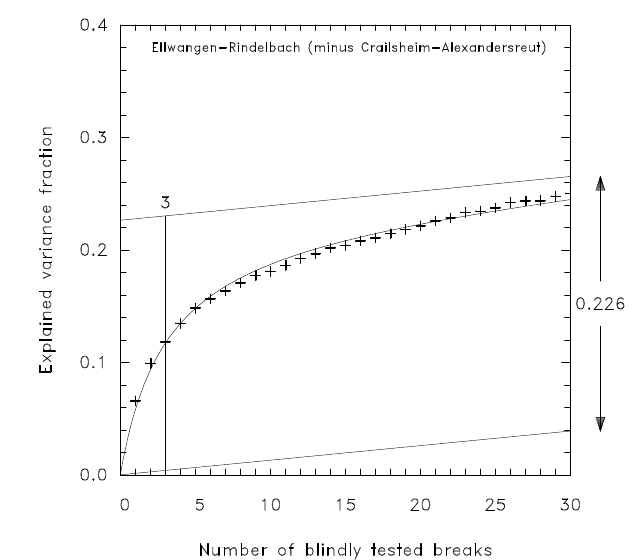
Figure 6. Estimation of break variance (0.226) and number (3) for the station pair Ellwangen-Rindelbach minus Crailsheim-